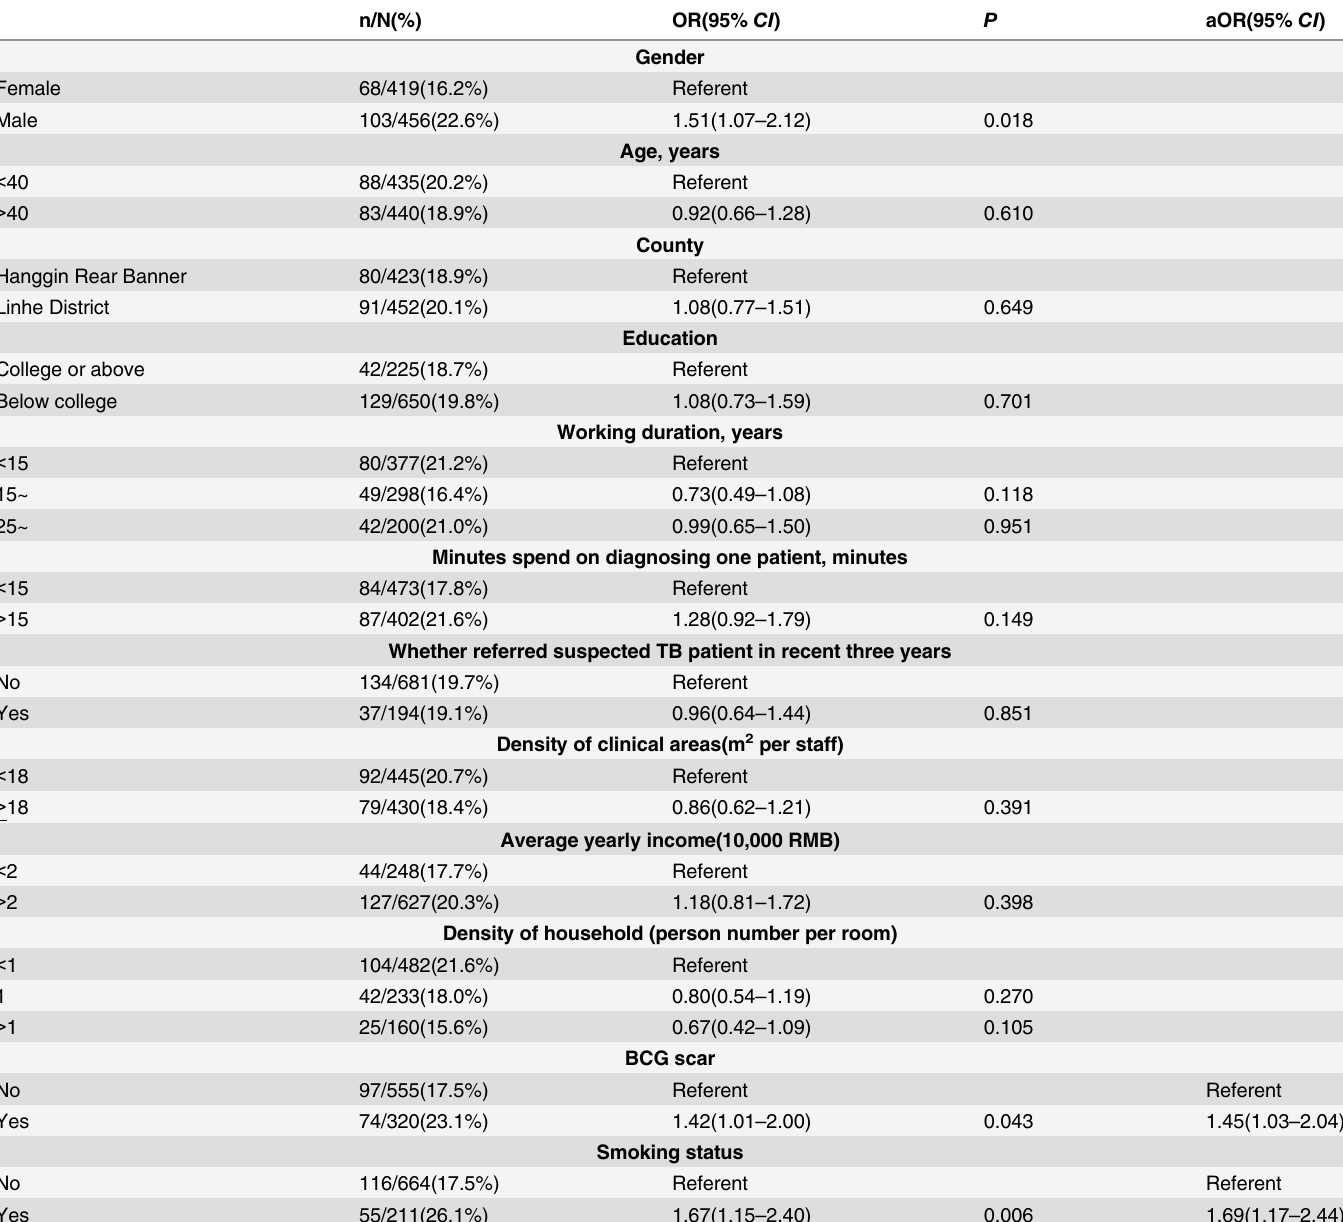
Table 2. The prevalence of LTBI detected by TST ( > 10mm) and its associated factors among village doctors in